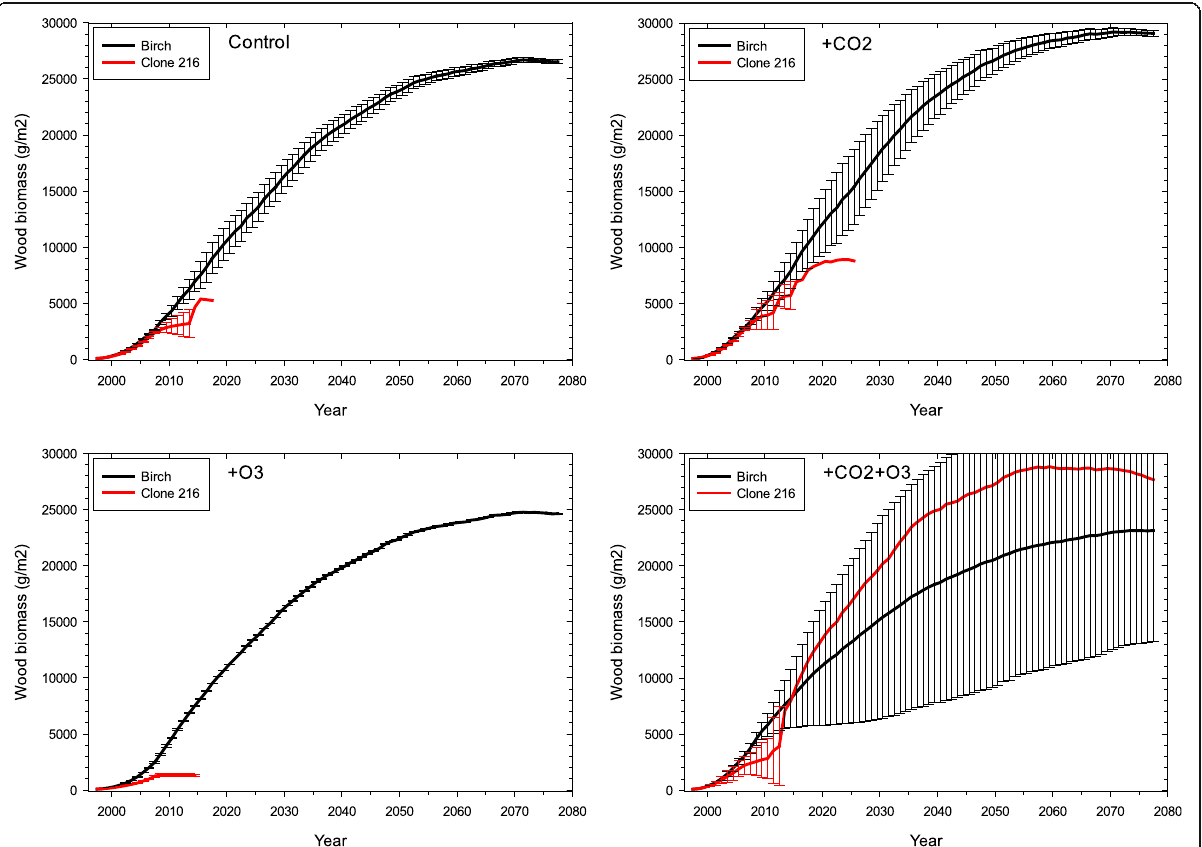
Fig. 6 Extrapolation by simulation 80 years into the future of the birch-aspen Section of the Aspen-FACE experiment. Error bars show one standard deviation of three